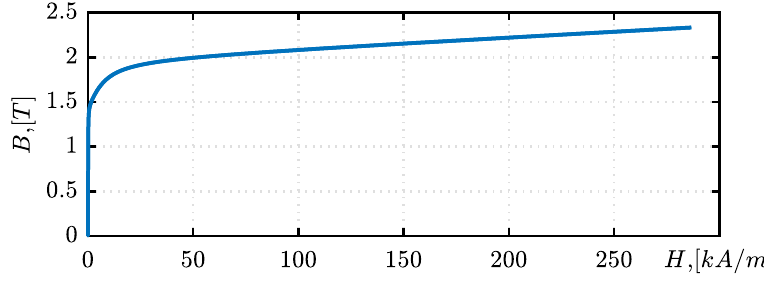
Figure 5. B–H curve of M270-50A.